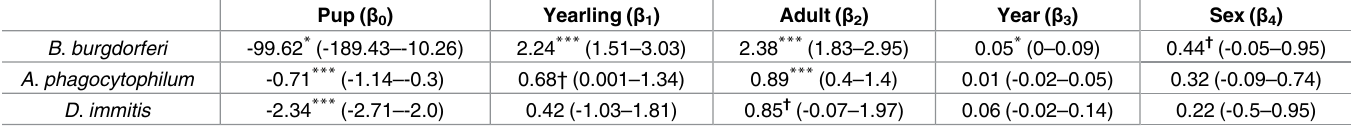
Table 1. Parameterestimatesfor logistic regression models of seroprevalence to Borrelia burgdorferi , Anaplasma phagocytophilum , and Dirofi- laria immitis .